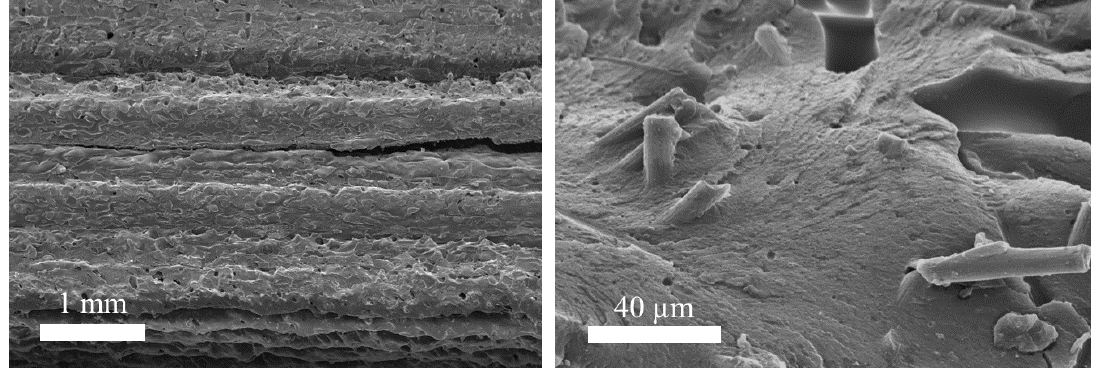
Figure 10. The fracture surfaces for LH 0.3 at a strain rate of 250 s − 1 .